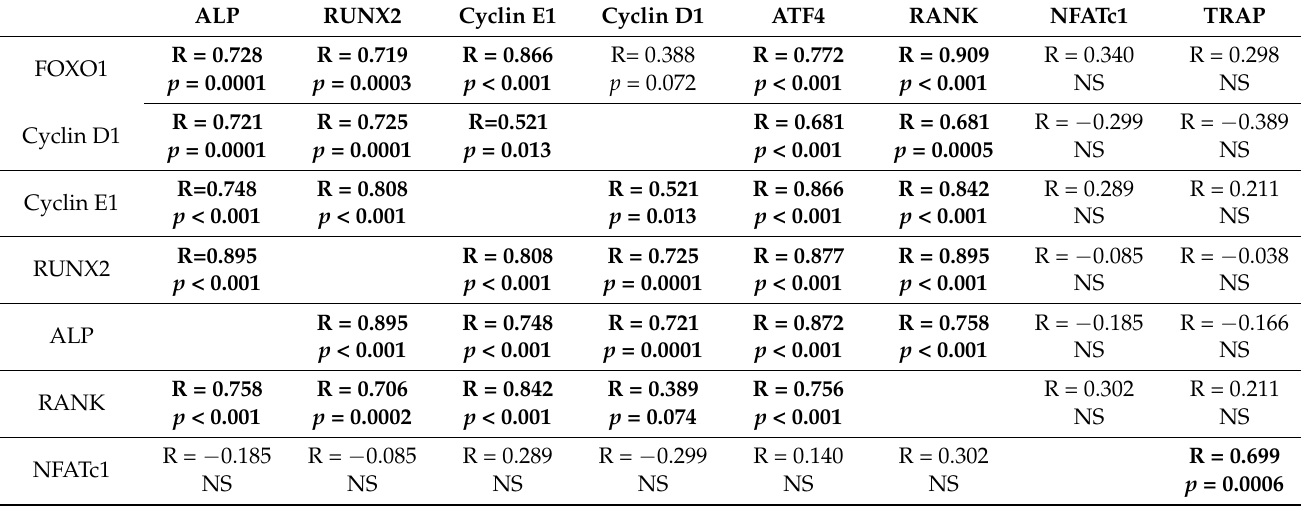
Table 2. The interrelationship between genes involved in osteoblastogenesis and RANK gene expression. ALP RUNX2 Cyclin E1 Cyclin D1 NFATc1